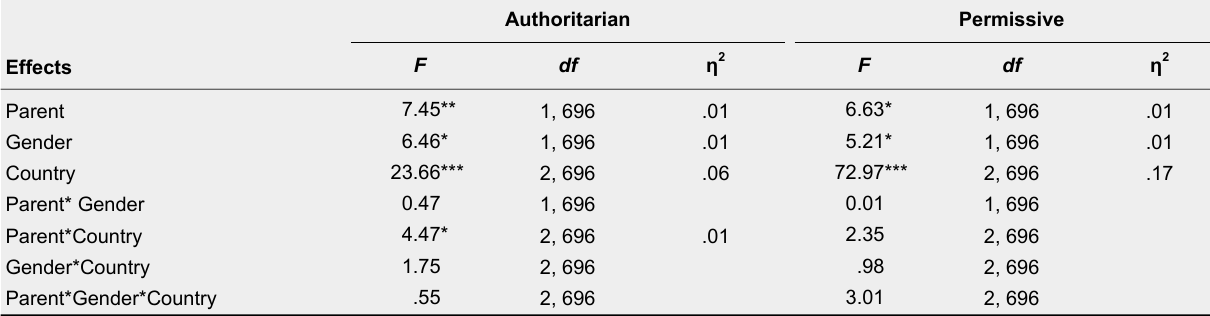
Principal and Interaction Effects for Authoritarian and Permissive Parenting Styles